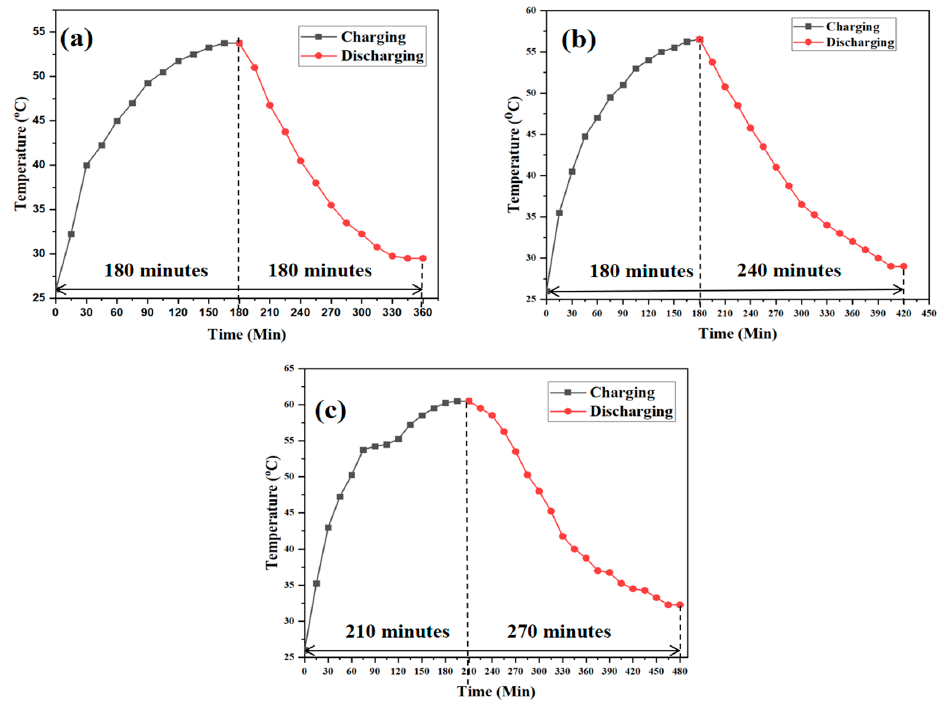
Figure 6. Temperature curves of the paraffin/steatite composite during the charging and discharging phase: ( a ) PW, ( b ) PCMS, and ( c ) PCMSB .